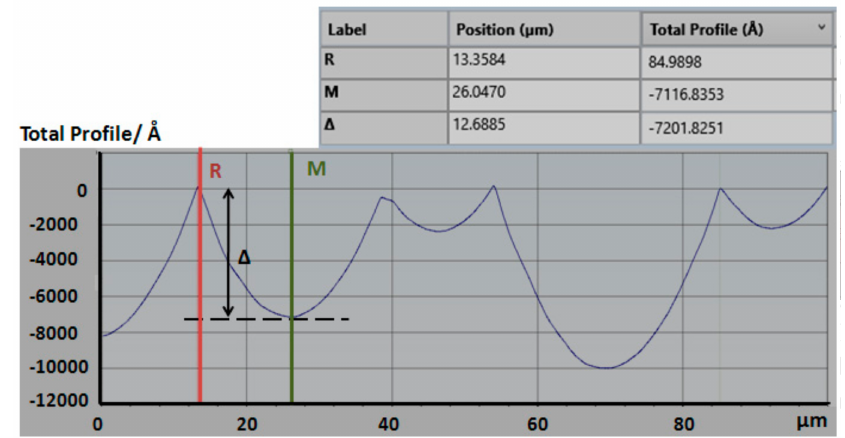
Figure 6. The surface profile of the microwell array.